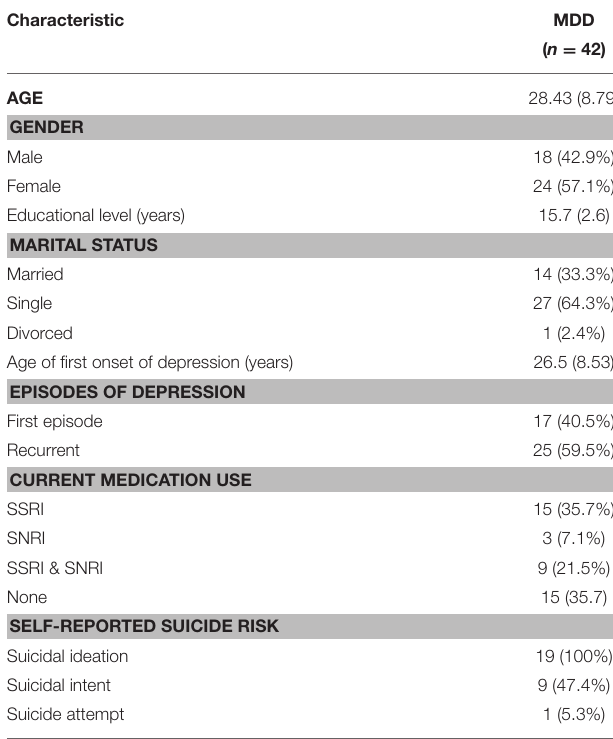
TABLE 4 | Demographic and clinical characteristics of MDD